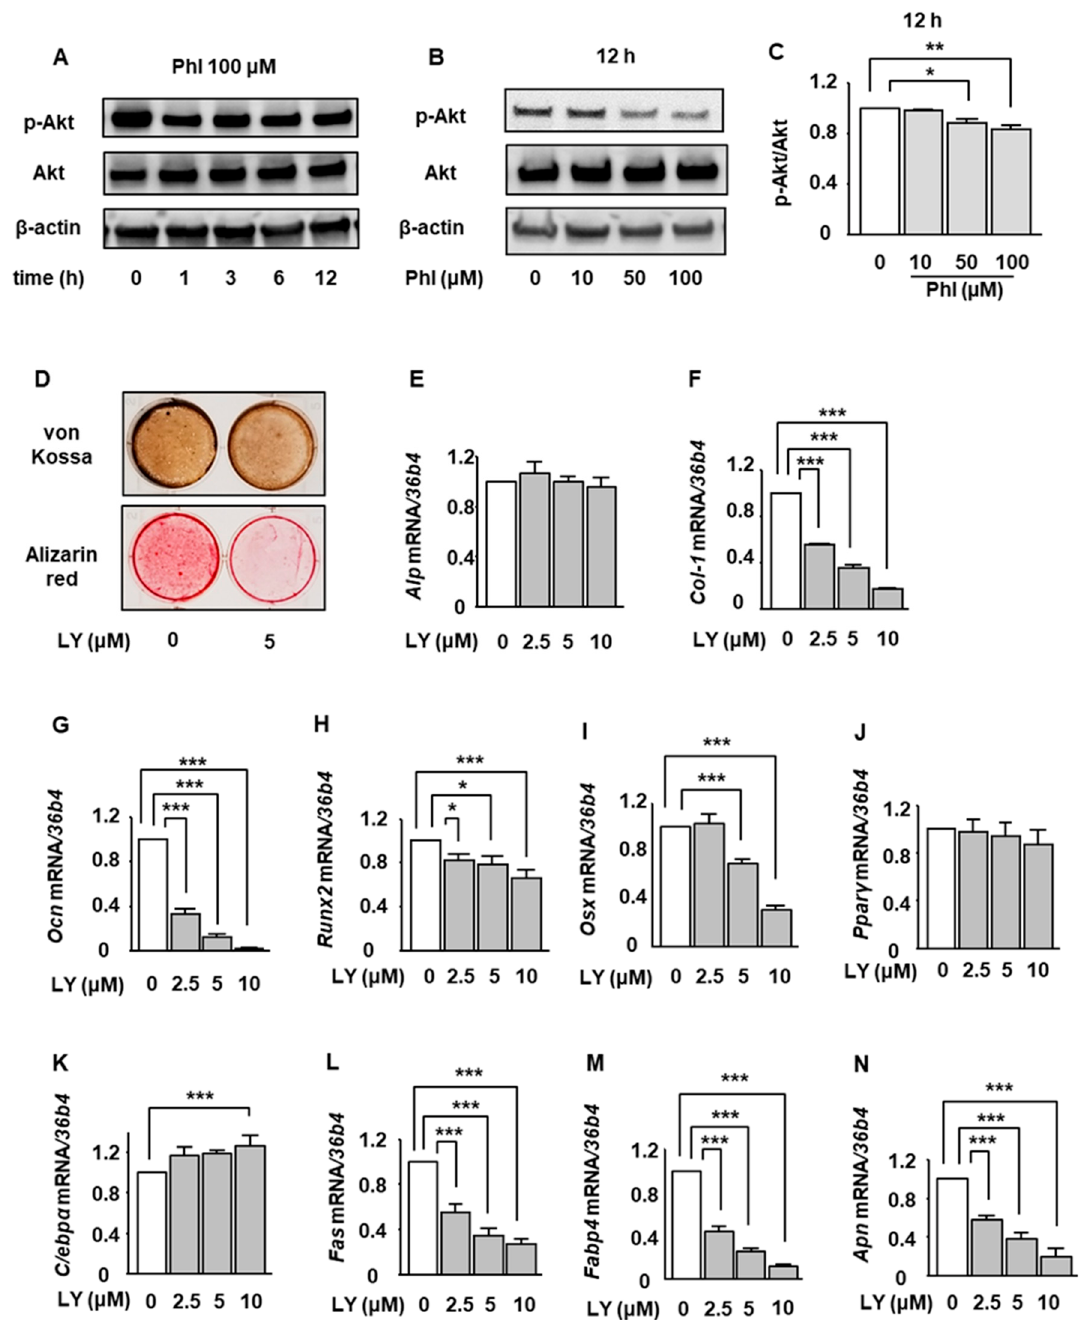
Figure 4. The involvement of suppression of PI3K / Akt pathway in the phloretin-induced downregulation of osteoblast di ff erentiation markers and upregulation of adipocyte di ff erentiation markers during BMP-2-induced osteoblastogenesis in ST2 cells. ( A – C ) After reaching confluence, ST2 cells were incubated in osteoblast di ff erentiation medium for 2 days. Thereafter, the cells were treated with 100 µ M phloretin for up to 12 h, total protein was extracted, and western blot analysis was performed to examine the time-dependent e ff ect of phloretin on Akt ( A ). To test dose-dependency, the cells were treated with phloretin (0 to 100 µ M) for 12 h ( B ). Quantification of the bands was performed ( C ). The results are representative of three experiments. Quantification results are expressed as mean ± SE ( n = 3). * p < 0.05, ** p < 0.01. ( D ) After reaching confluence, ST2 cells were incubated in osteoblast di ff erentiation medium with 0 or 5 µ M LY294002, and von Kossa staining and Alizarin red staining were performed on day 14. ( E – N ) After reaching confluence, ST2 cells were incubated in osteoblast di ff erentiation medium with 0 to 10 µ M LY294002. Total mRNA was extracted on day 3, and the mRNA expression of osteoblastogenic markers ( Alp , Col-1 , Ocn , Runx2 , and Osx ) and adipogenic markers ( Pparg , C / ebpa , Fas , Fabp4 , and Apn ) was examined by real-time PCR. The results are expressed as mean ± SE ( n ≥ 5). * p < 0.05, ** p < 0.01, *** p < 0.001. Phl; phloretin, LY;